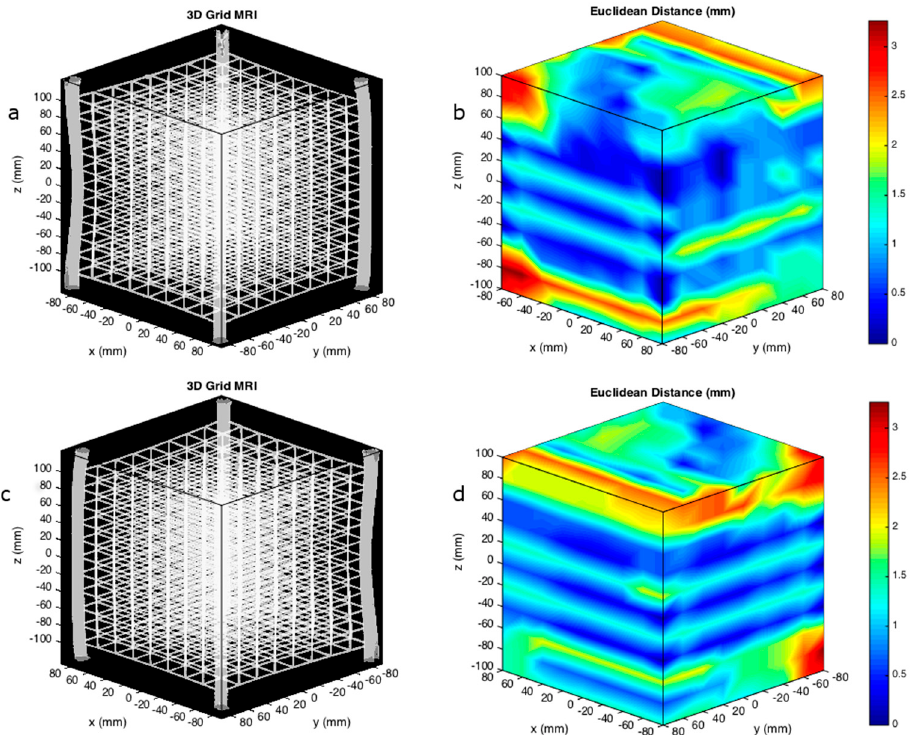
Figure 3. ( a ) 3D Surface rendering of the grid phantom for the data acquired using system D (azimuth 45°, elevation 20°); ( b ) associated Euclidean distance error volume (azimuth 45°, elevation 20°); ( c ) same as (a) but showing opposing faces (azimuth 225°, elevation 20°); and ( d ) associated error volume